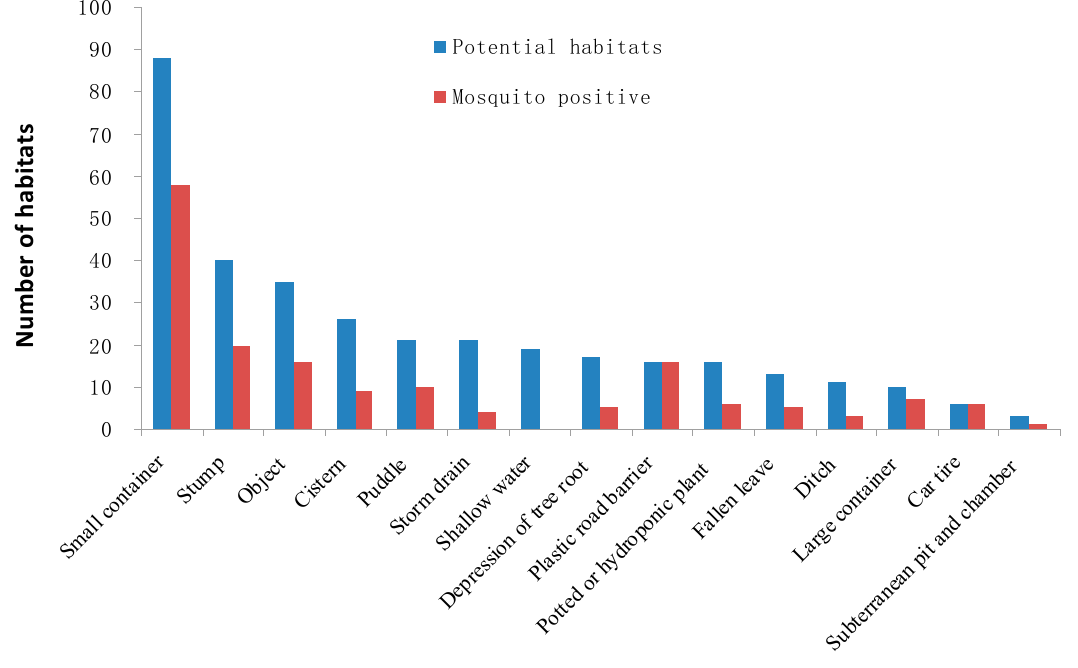
Figure 3. Numbers of potential habitats and mosquito-positive habitats by habitat type in Guangzhou.